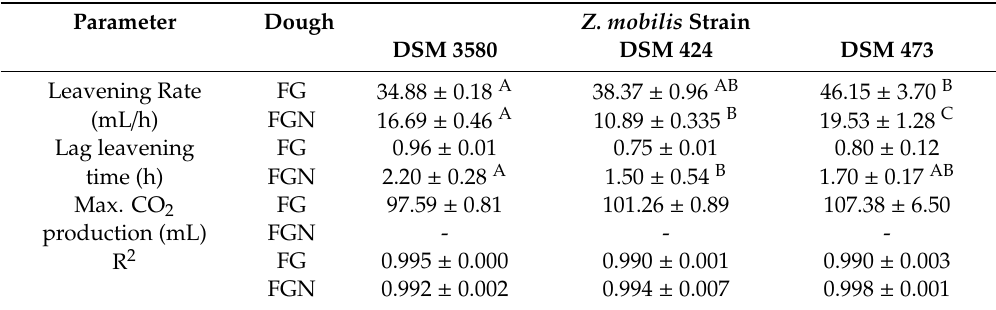
Table 3. Kinetic parameters (Leavening rate, lag leavening time, maximum CO 2 production) of dough samples leavened with di ff erent Z. mobilis strains (DSM 3580, 424 and 473) in presence of glucose only (FG) or glucose and NaCl (FGN), as computed by DMFit [17] (model R 2 also